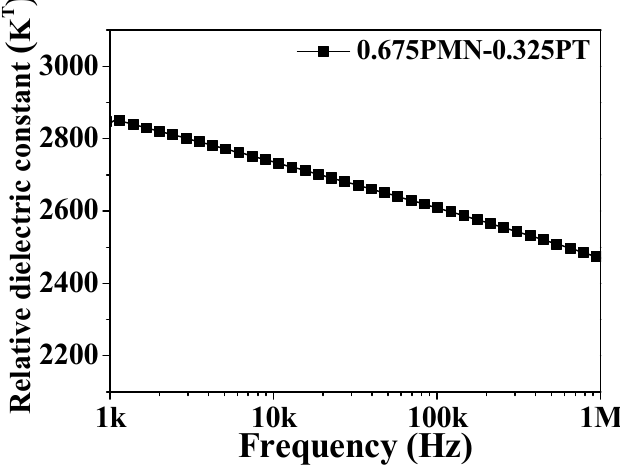
Figure 4. The frequency dependent relative dielectric constant of the 0.675PbMgNbO 3 -0.325PbTiO 3 .